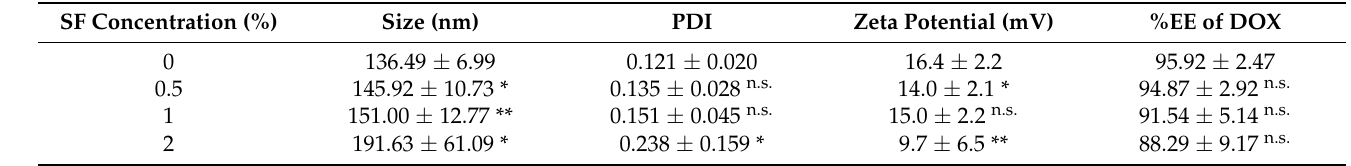
Table 1. Physicochemical properties of liposomes and encapsulation efficiency (%EE) of DOX. SF Concentration